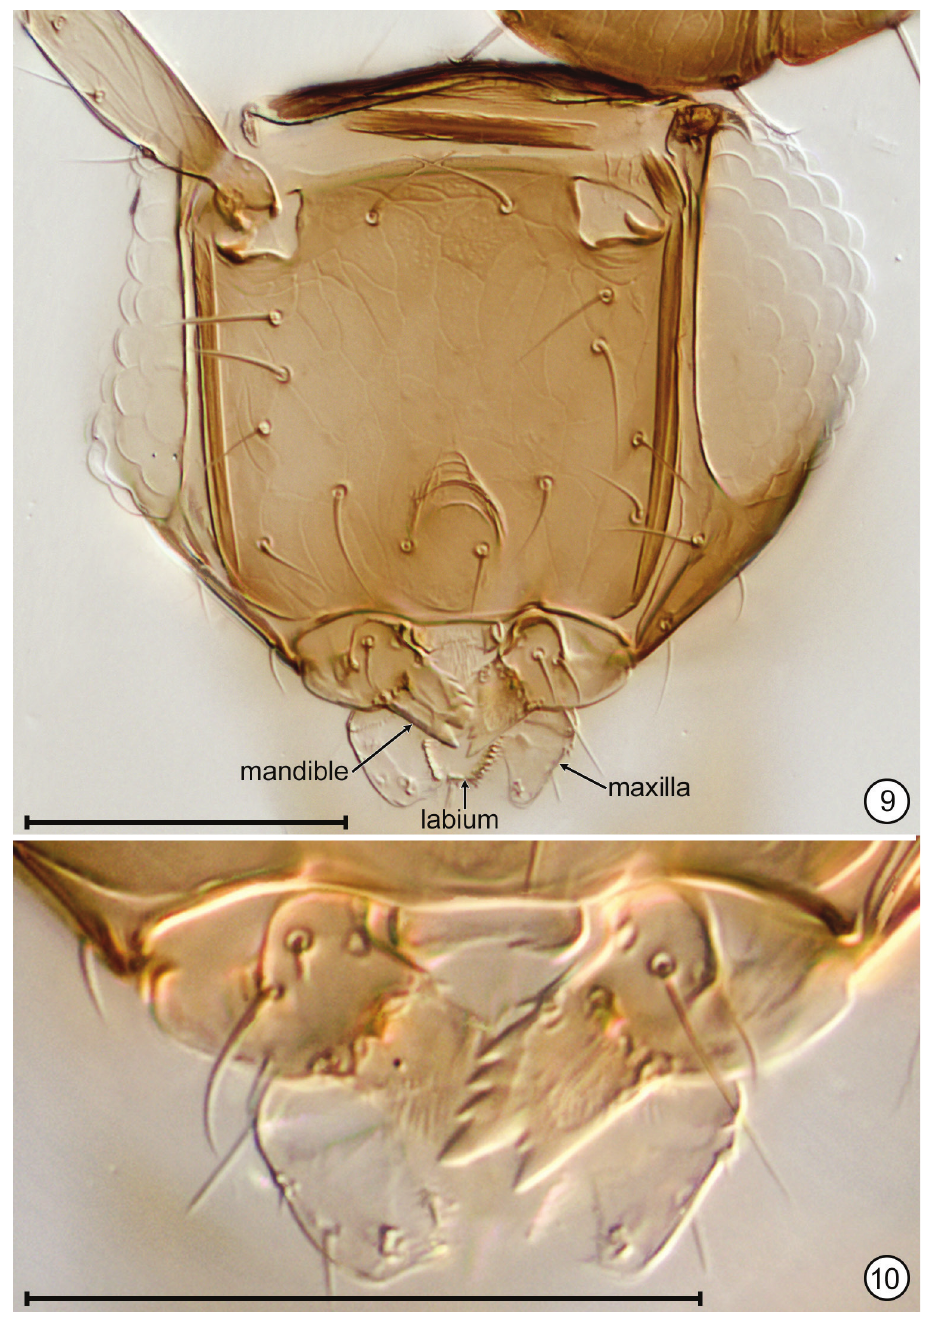
Figures 9, 10. Anaphes quinquearticulatus , paratype 9 head, anterior showing other mandible 10 mouth- parts. Scale bars: 50